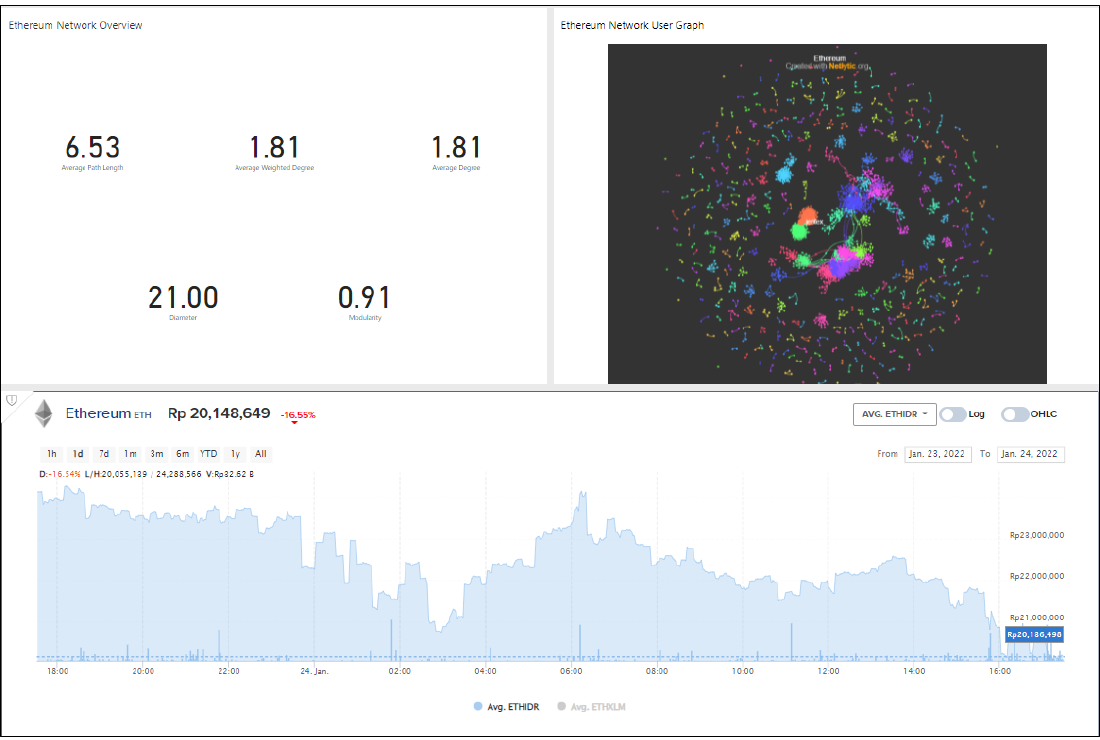
Figure 4(c). Binance Coin’s Network Overview